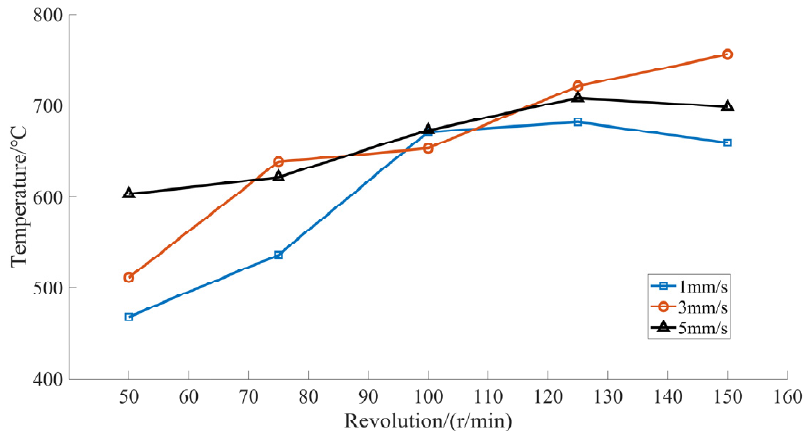
Figure 12. In fl uence of blade speed on sawing temperature. Figure 12. Influence of blade speed on sawing